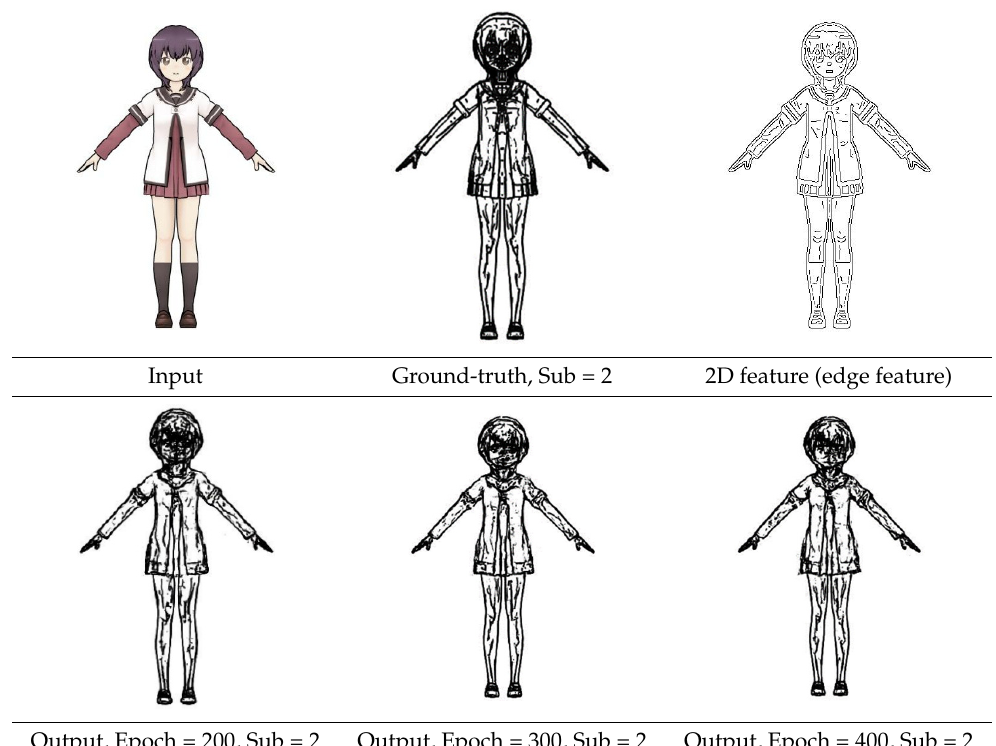
Table 5. Result of the line drawing extraction using a conditional GAN (Example 3).